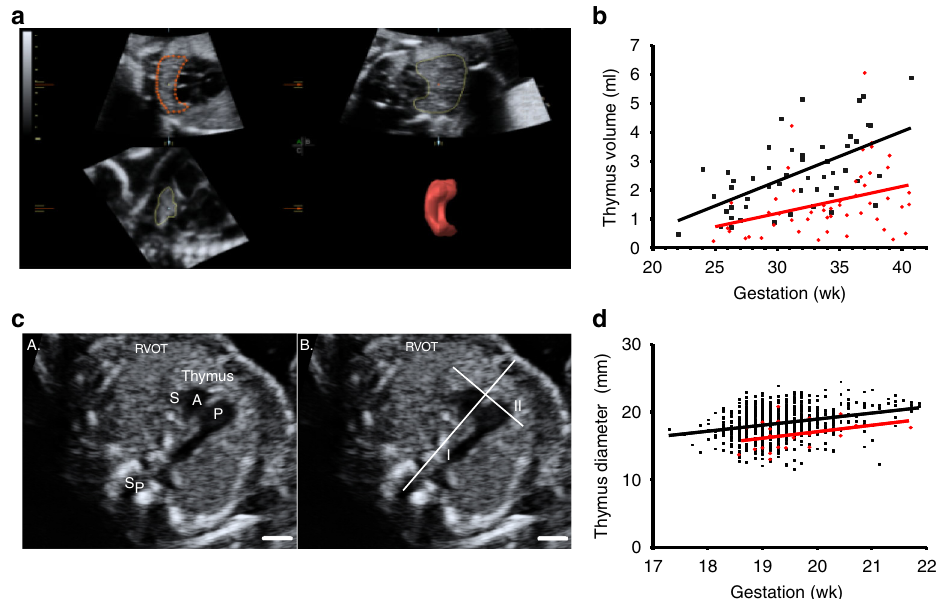
Fig. 1 Impaired fetal thymic development in preeclampsia. a Nepean cohort 1 : Virtual organ computer-aided analysis calculation of the fetal thymus volume at 26 weeks of gestation, showing three orthogonal planes (left top: transverse, right top: coronal, left down: sagittal) and reconstructed thymus volume (right down). b Dot plot showing fetal thymus volumes in different gestational weeks in both non-preeclamptic ( n = 50, black dots) and preeclamptic ( n = 50, red dots) groups. Mean± SD: 2.6 ± 1.3 mL and 1.6 ± 1.2 mL, respectively ( p < 0.001, unpaired t- test). c Nepean cohort 2 : Fetal thymus diameter measurement: an axial view of the fetal thymus was obtained, within a standard image of the right ventricular out fl ow tract (RVOT). Then a line was drawn connecting the fetal spine and sternum (I). Fetal thymus diameter was measured as its greatest diameter (II), perpendicular to line I. Sp = spine, S = superior vena cava, A = aorta, P = pulmonary artery. Scale bar = 5 mm. d Dot plot showing fetal thymus diameter in different gestational weeks in both non-preeclamptic ( n = 863, black dots) and preeclamptic ( n = 24, red dots) groups, adjusted means were 18.3 mm and 16.5 mm, respectively ( p < 0.001, unpaired t-